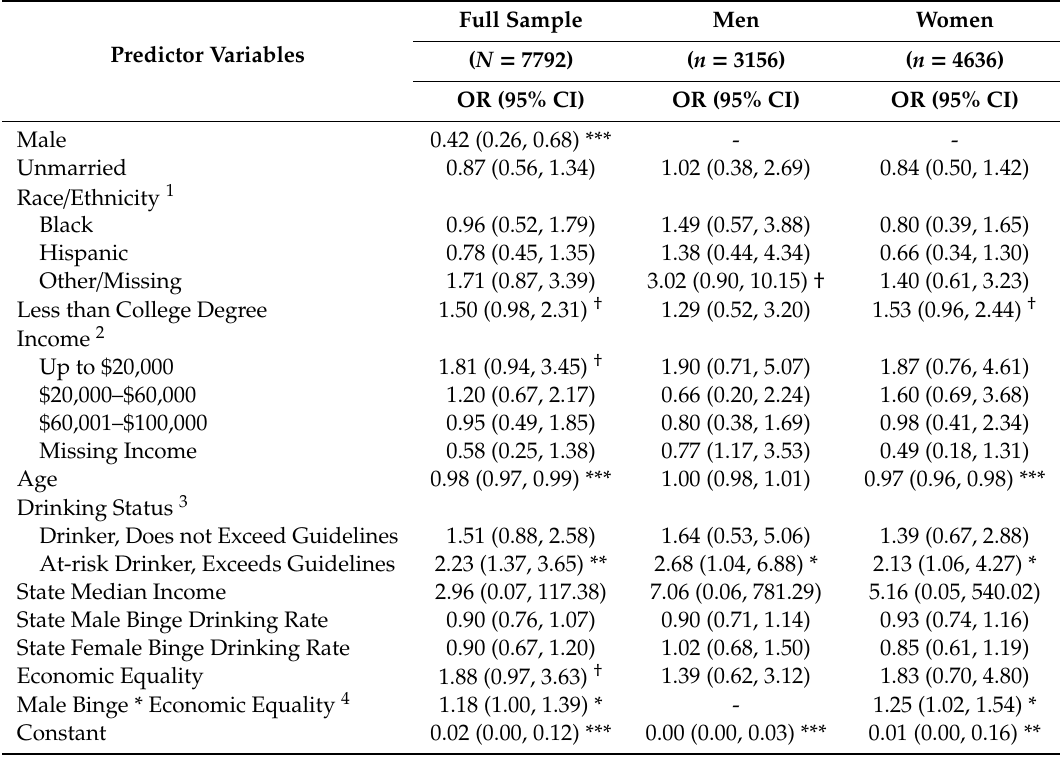
Table 5. Interactive associations of male binge drinking rates and economic equality with harm from drinking spouse / partner.